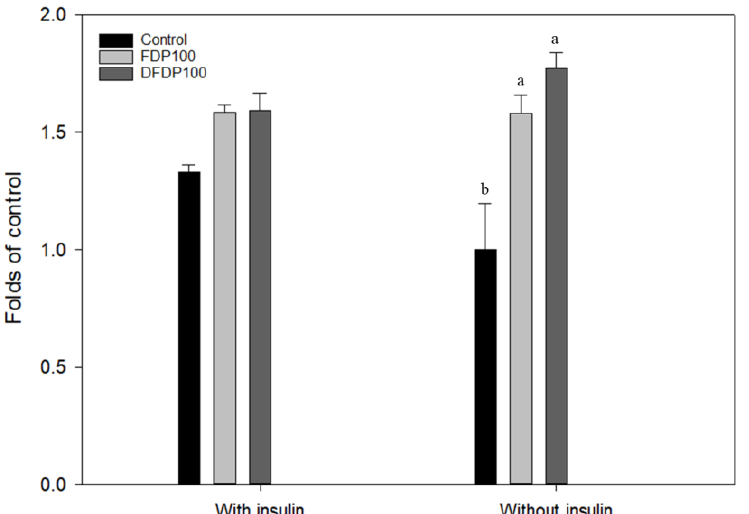
Figure 2. Effects of ethanol extracts from fermented dairy products and Taiwan djulis fermented dairy products on glucose utilization in the liver cells of FL83B cell. Control: FL83B cell without treatment; FDP: Fermented dairy products ethanol extraction; DFDP: Taiwan djulis fermented dairy products ethanol extraction. The experiment was performed in triplicate and expressed as mean ± SD. Different letters indicate significant differences from each other.